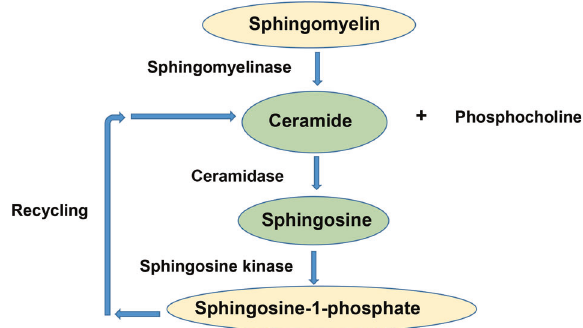
Fig. 1 Catabolic pathway of sphingomyelin to generate ceramide and subsequent sphingosine-1-phophate. Acid sphingomyelinase (ASM) converts sphingomyelin to liberate ceramide and phospho- choline in the lysosome and on the plasma membrane. Ceramide is hydrolyzed by ceramidase to form sphingosine, which is subse- quently phosphorylated by sphingosine kinase to generate sphingosine-1-phophate